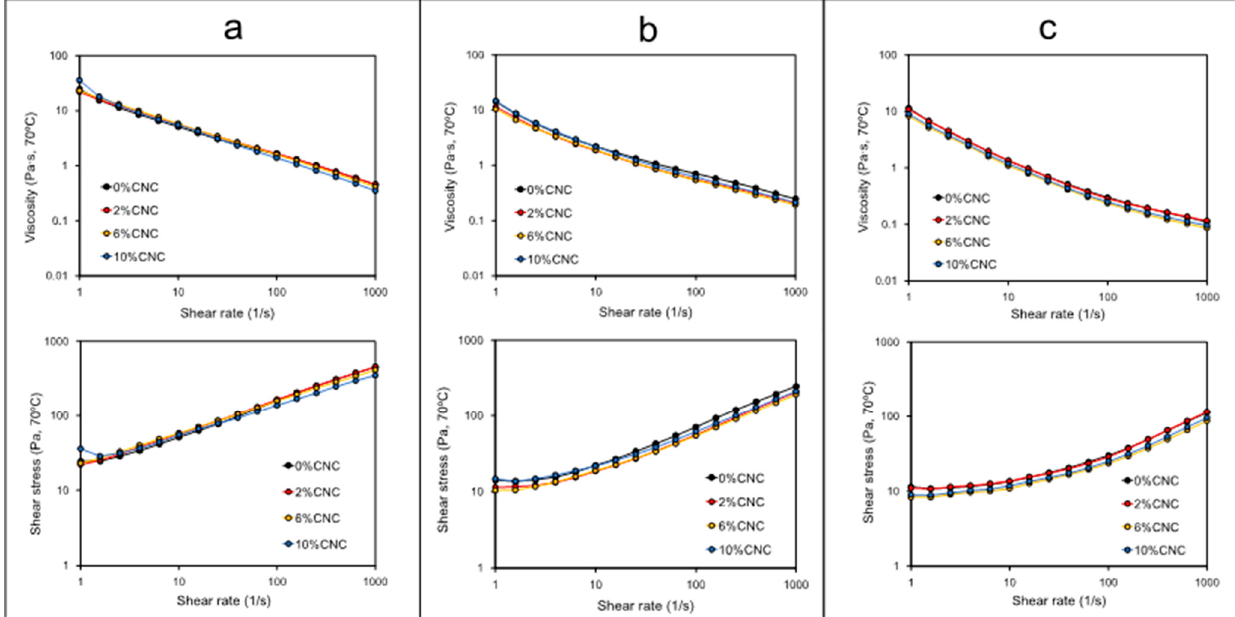
Figure 3. Flow curve in gelatinized starch samples at 70 °C and at different concentrations of CNCs: ( a ) potato; ( b ) wheat; and ( c ) waxy maize. Top plots correspond to apparent viscosity as a function of shear rate, whereas bottom plots correspond to shear stress as a function of shear rate.